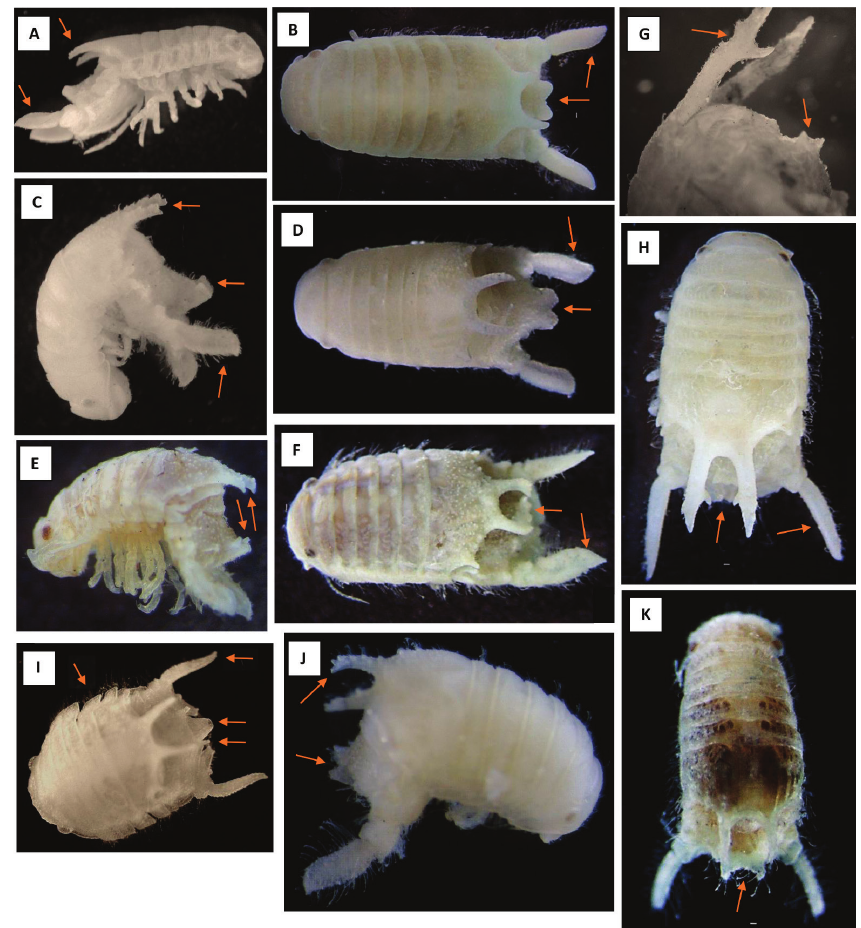
Figure 2. Main features of adult males (stage 8) of the NE Atlantic-Black Sea axis Dynamene spp. A, B D. bidentata (S. Wales). Arrows indicate shape of the bidentate process ( A ), uropods ( A, B ) and pleotelsonic boss ( B ) C, D D. magnitorata (Roscoff, France). Arrows indicate shape of the bidentate process ( C ), the uropods ( C, D ) and the pleotelsonic boss ( C , D ). Note the difference in the shape of the boss and the ends of the arms of the bidentate process to those of D. bidentata E, F D. edwardsi ( E Cana- ries F Azores). Arrows indicate shape of the bidentate process ( E, F ), uropods ( F ) and pleotelsonic boss ( E, F ). Specimen in E shows relatively little dorso-lateral setation, whilst that in F is hirsute. Note the differences in the shape of the boss and the tips of the arms of the bidentate process compared to those of D. bidentata and D. magnitorata G, H D. bifida (France, Mediterranean). Arrows indicate shape of the bidentate process ( G, H ), uropodal exopod (H) and pleotelsonic boss ( G ). Note the large accessory pro- cess on each arm of the bidentate process, the small sessile pleotelsonic boss and the long narrow uropodal exopods I D. tubicauda (Bay of Naples, Italy). Arrows indicate the unique body shape, tubular respiratory channel, peg-like pleotelsonic bosses, and the curved uropodal exopods J, K D. bicolor (Bay of Naples, Italy). Arrows indicate shape of the bidentate process ( J ), and pleotelsonic boss ( J, K ). Note in particular the rugose nature of the dorsal surface of the bidentate arms, and the triangular shape of each half of the boss – in specimens from the Black Sea the boss is of a similar shape but much less